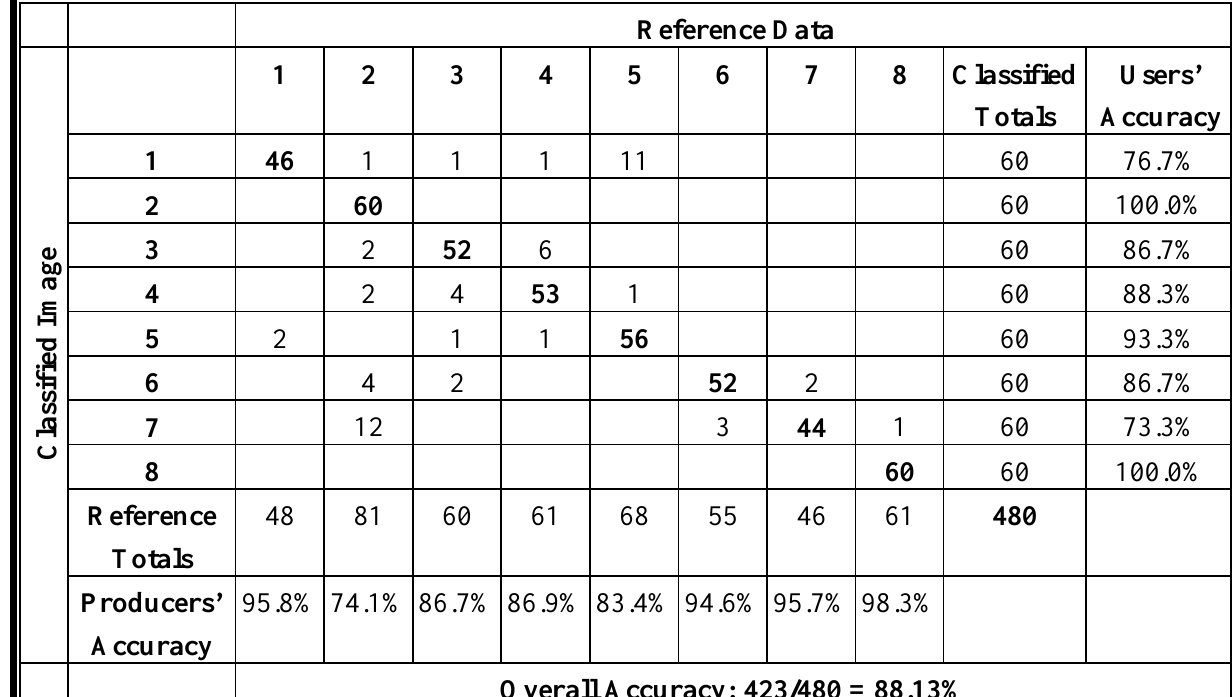
Table 2. Error matrix on the classified map from the MLP